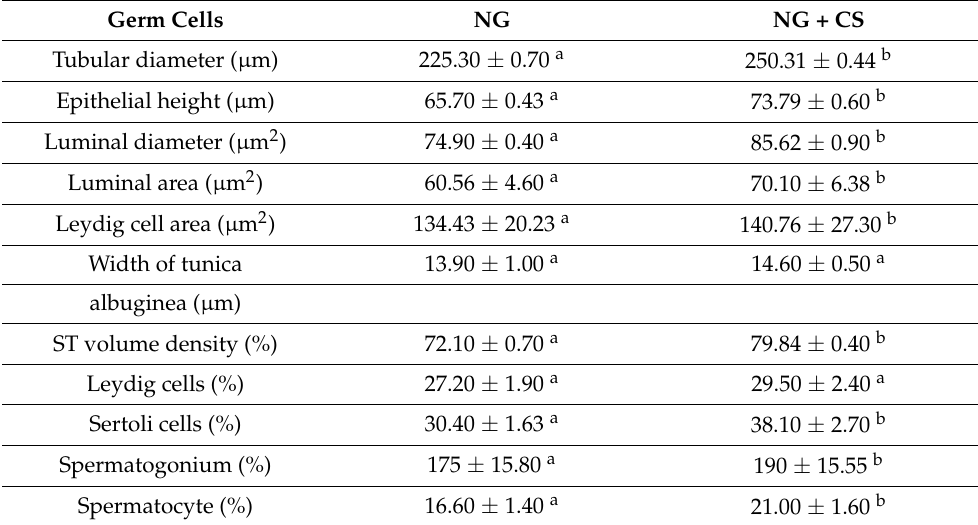
Figure 9. Morphological evaluations of yak testes under different feeding conditions: ( A – C ) natural grazing without concentrate supplementation; ( D – F ) natural grazing plus concentrate supplemen- tation. Structures which were found: PS (primary spermatocyte), My (myoid cell), C (capillary), L (Leydig cell), ST (seminiferous tubule), S (spermatogonium), ES (elongated sperma). Table 4. Diameters of seminiferous tubules and numbers of cells in the testes of yaks under different feeding conditions (mean ±